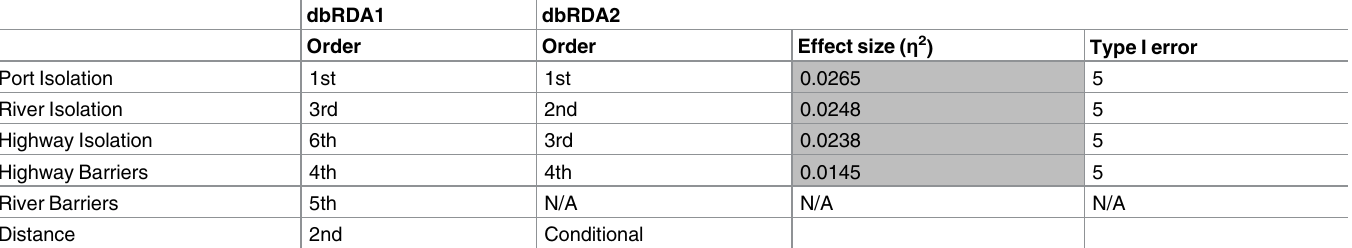
Table 2. Results of dbRDA1 and dbRDA2. The order of inclusionof variablesis indicatedfor each model. Cells containing the effect sizes of variables retainedin dbRDA2that are shadedindicatesignificanceat P < 0.01. The numberof type I error simulations (out of 100) showingsignificance is indicatedfor each variable in